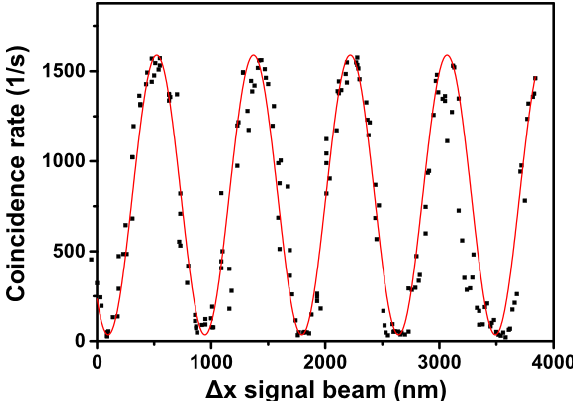
Figure 3. Counting rate for single signal photons at Detector A in coincidence with single idler photons at Detector B as a function of the signal path delay as in Figure 2, but with higher resolution.